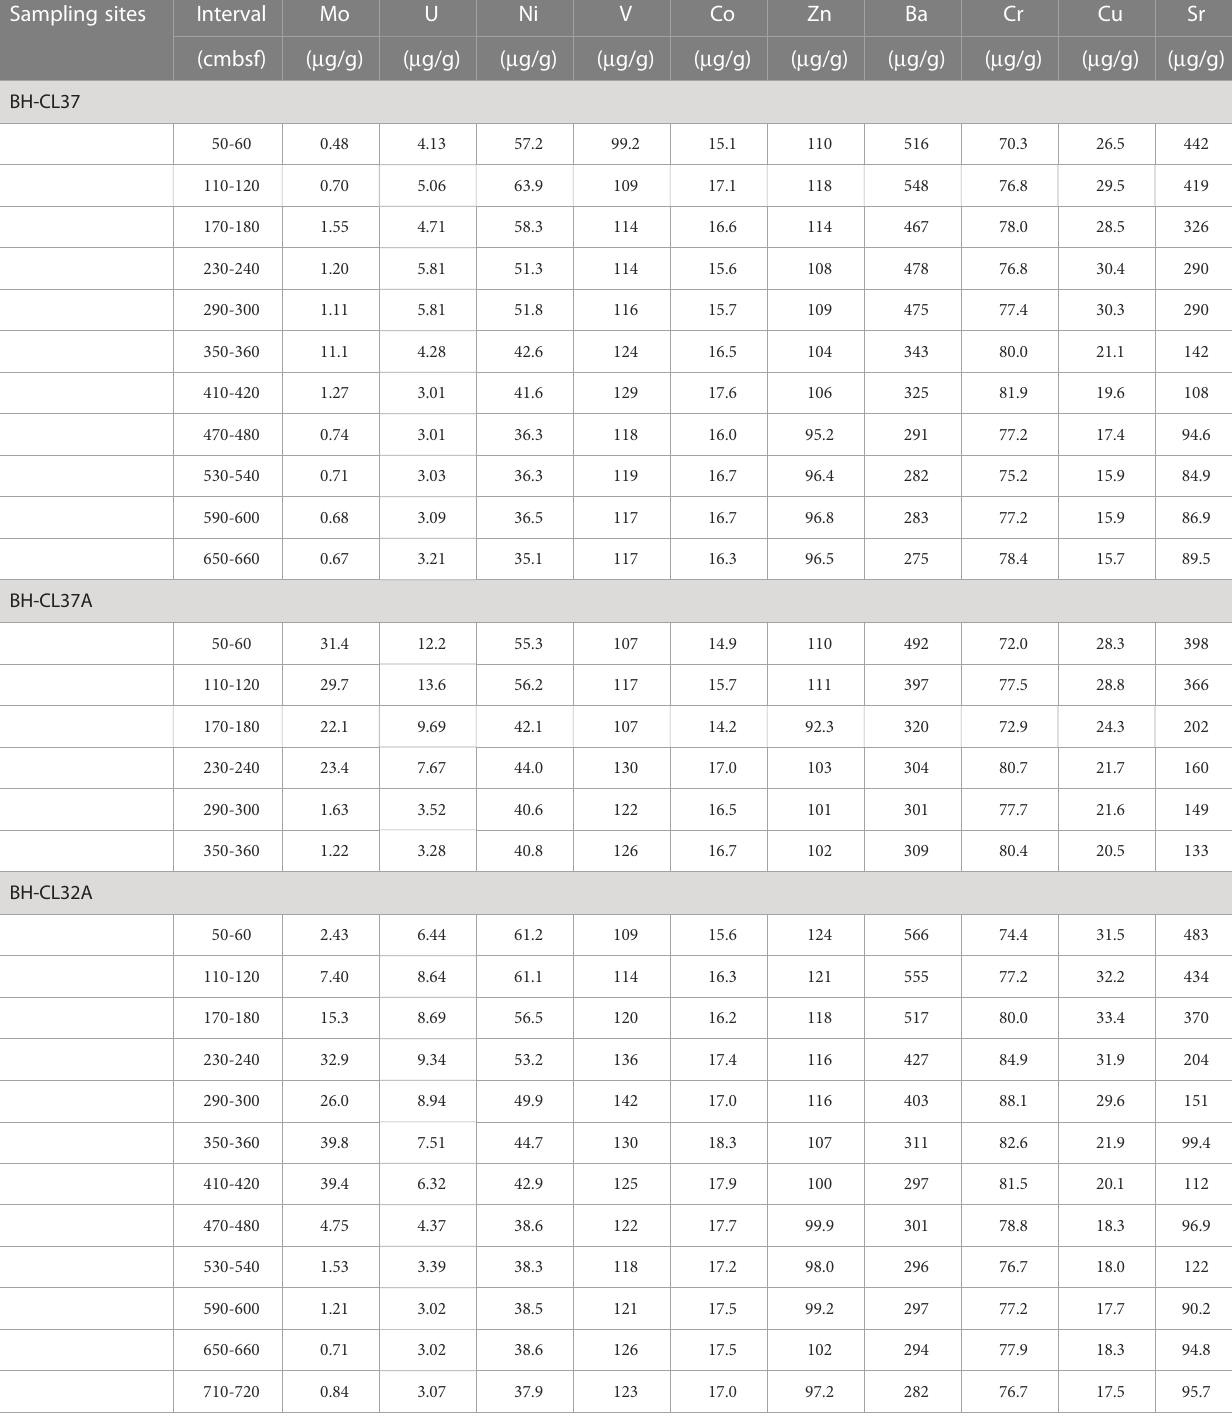
TABLE 4 Concentration of some trace elements in sediments. Sampling